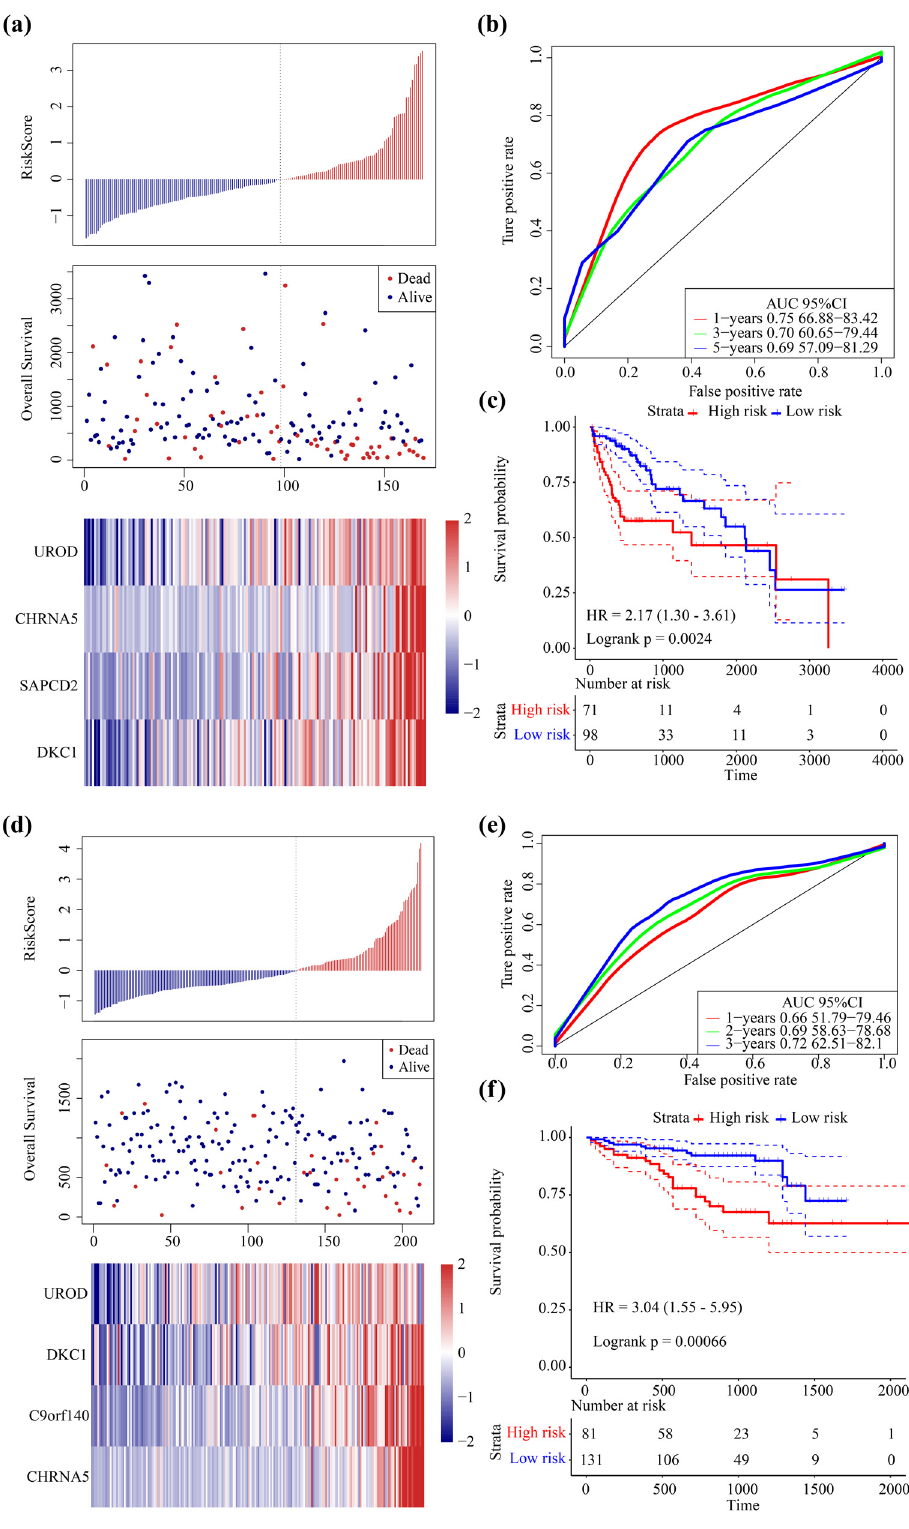
Figure 5: Robustness of 4 - mRNA signature: ( a ) risk score, survival time and survival status, and expressions of 4 - mRNAs in TCGA test set; ( b ) ROC curve and AUC of the 4 - mRNA signature; ( c ) KM survival curves distribution of 4 - mRNA signature in the TCGA test set; ( d ) the risk score, survival time and survival status, and expressions of 4 mRNAs in ICGC data set; ( e ) ROC curve and AUC of the 4 - mRNA signature; and ( f ) KM survival curve distribution of 4 - mRNA signature in the ICGC data